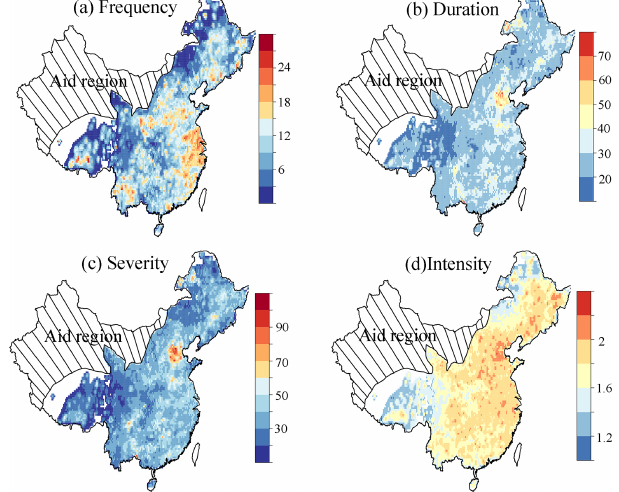
Figure 10. The spatial pattern of the key characteristics of com- pound dry and hot events in China from 1961 to 2018, using the threshold of − 0 . 8 in run theory. Frequency (a) refers to the total events during the historical period; duration (b) , severity (c) , and intensity (d) are the average values of all events. White color indi- cates there are no events. Only events lasting at least 2 weeks are considered.